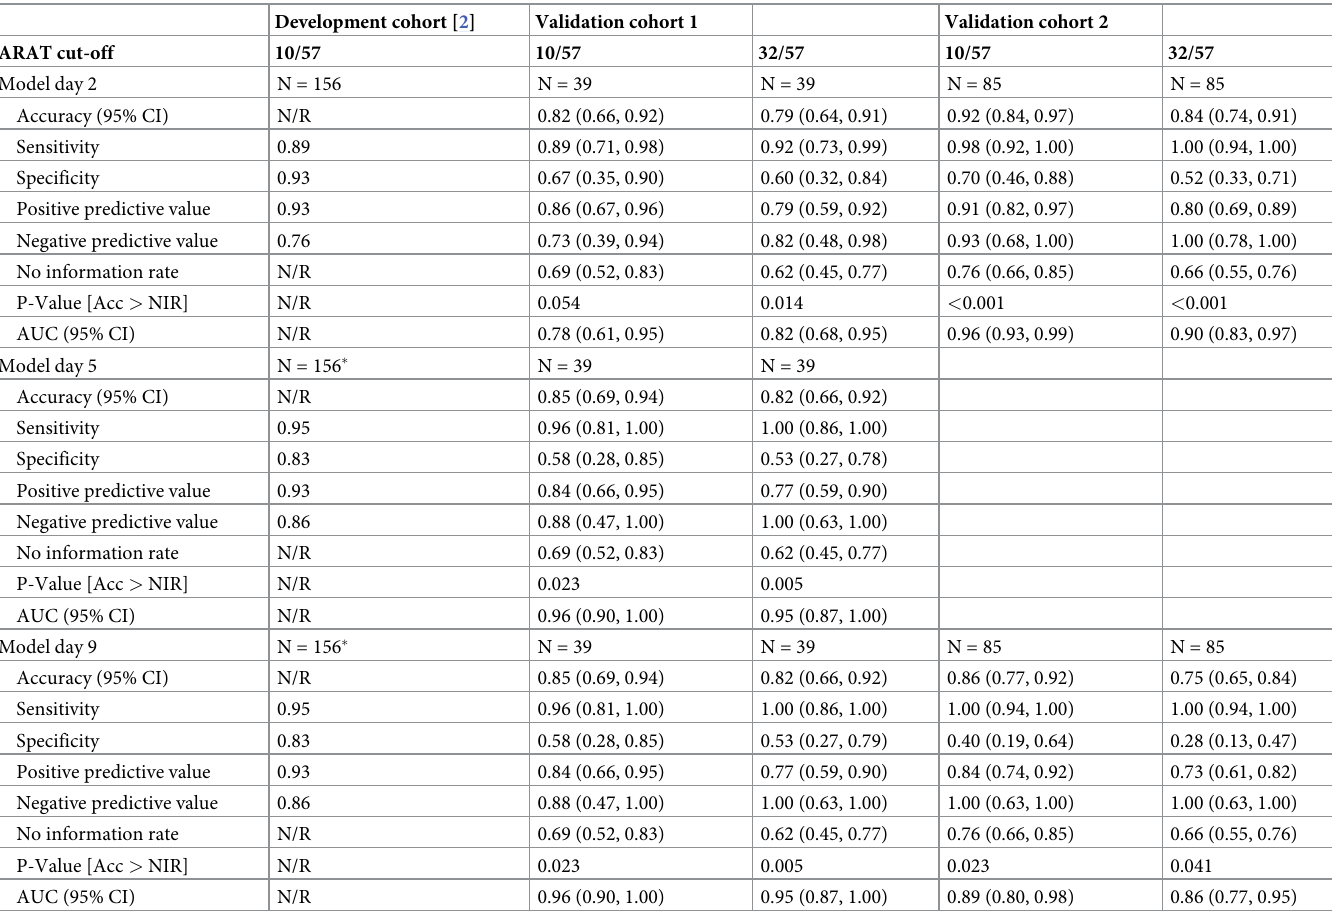
Table 3. Discrimination of the EPOS model in the development and validation cohorts for an ARAT cut-off at 10 and 32